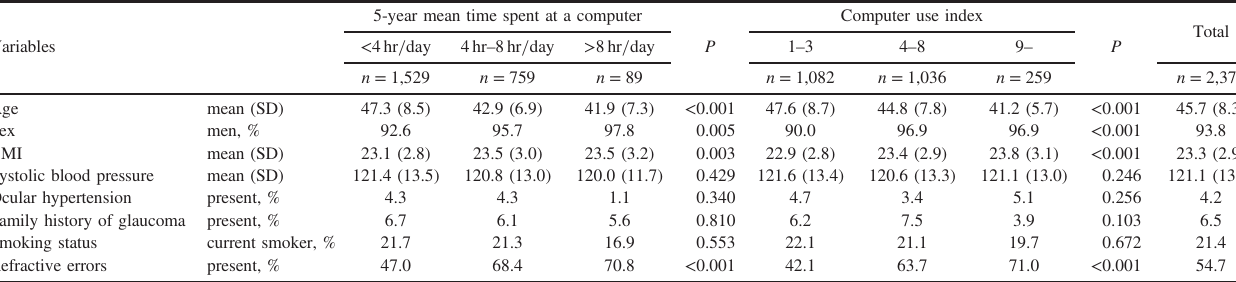
Table 1. Characteristics of study subjects Variables